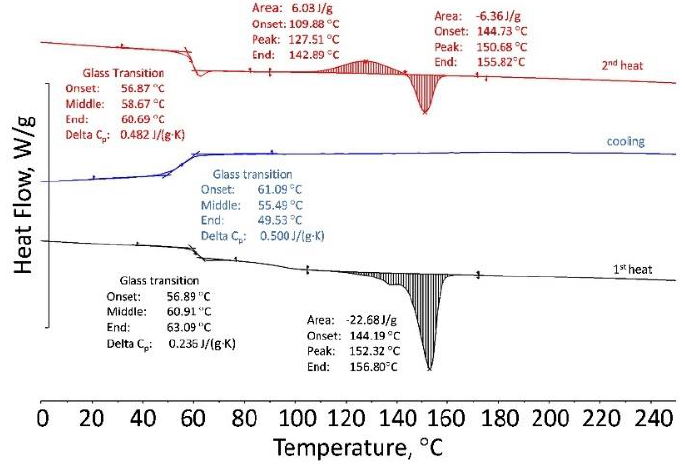
Figure 10. DSC curves of PLA.